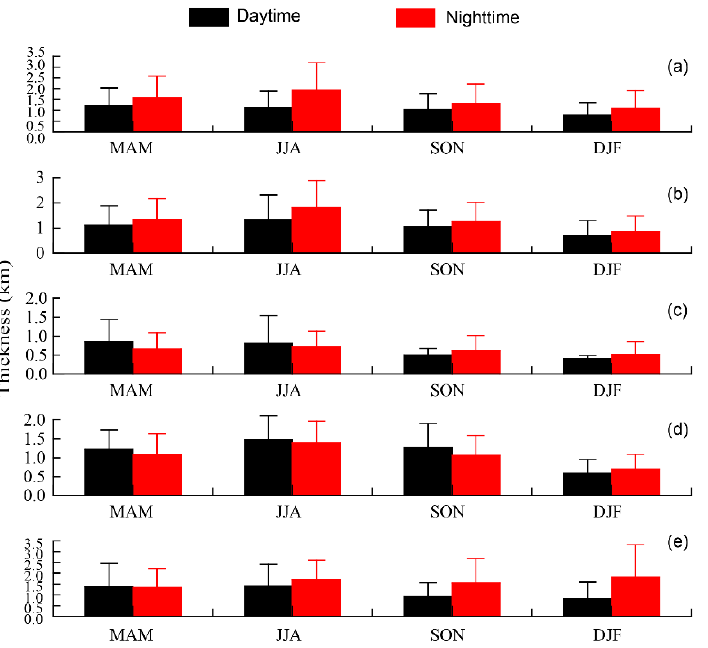
Figure 10. Variations in the mean thicknesses of aerosol subtype layer in the Aral Sea region in the daytime and nighttime from 2007 to 2021: ( a ) dust; ( b ) polluted dust; ( c ) clean continental; ( d ) polluted continental/smoke; ( e ) elevated smoke.